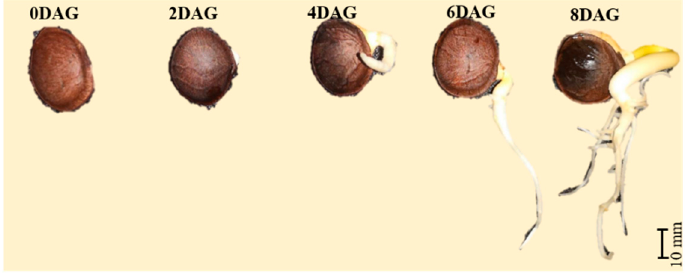
Figure 1. Germinated sacha inchi seeds at different germination days. DAG, days after germination.